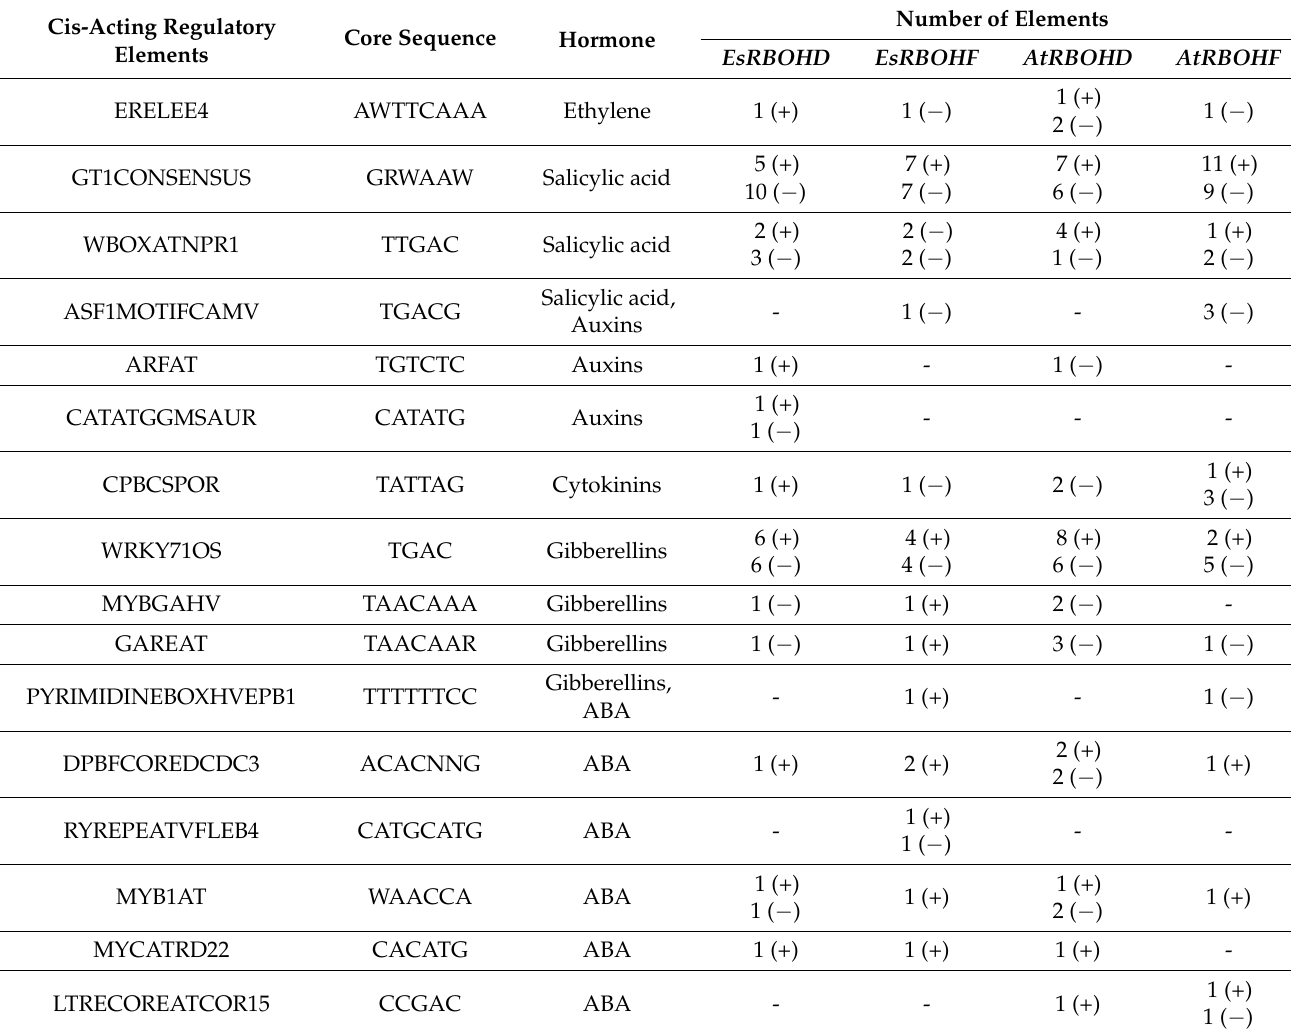
Table 1. Putative hormone cis -acting regulatory elements in EsRBOHD , EsRBOHF , AtRBOHD , and AtRBOHF promoters using the PLACE